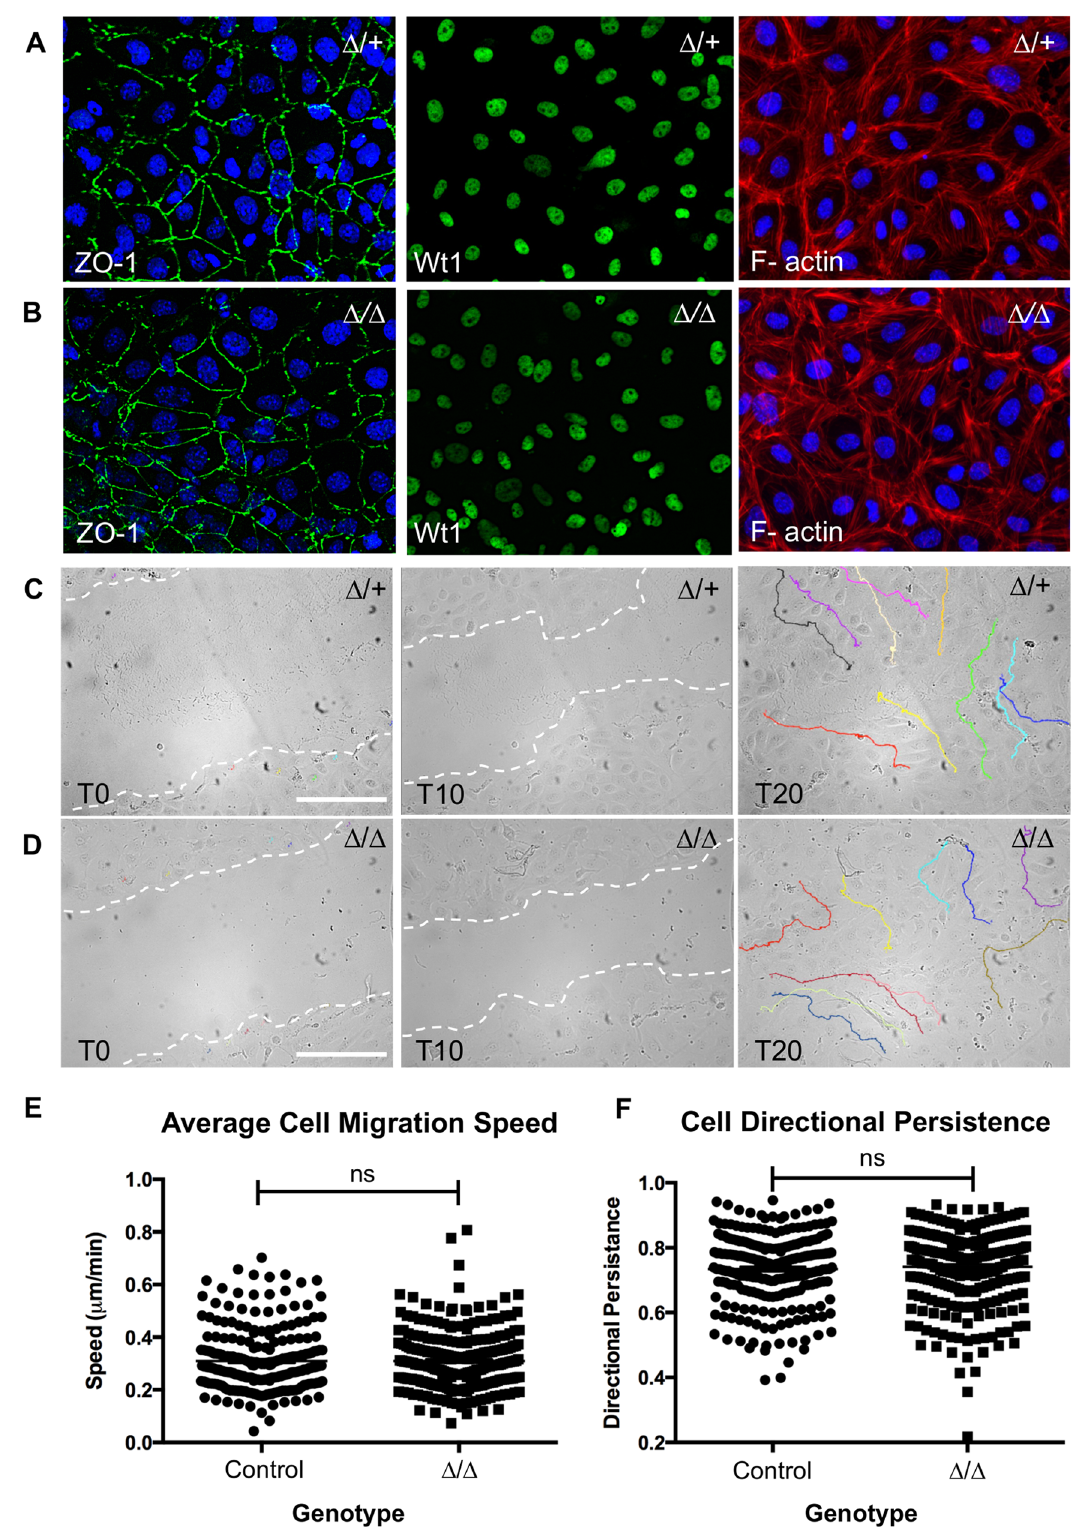
Fig 9. NMHC IIB ablated epicardial cells do not show migration defects in vitro . A: Cells cultured from E11.5 Myh10 Δ /+heterozygote and B: Myh10 Δ homozygous mutant heart explantsform an epicardial